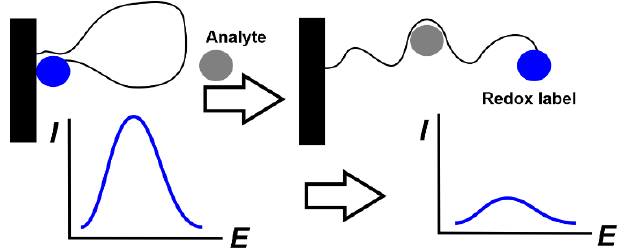
Figure 11. Detection of the signal with E-sensor based on labeled pinhole aptamer.